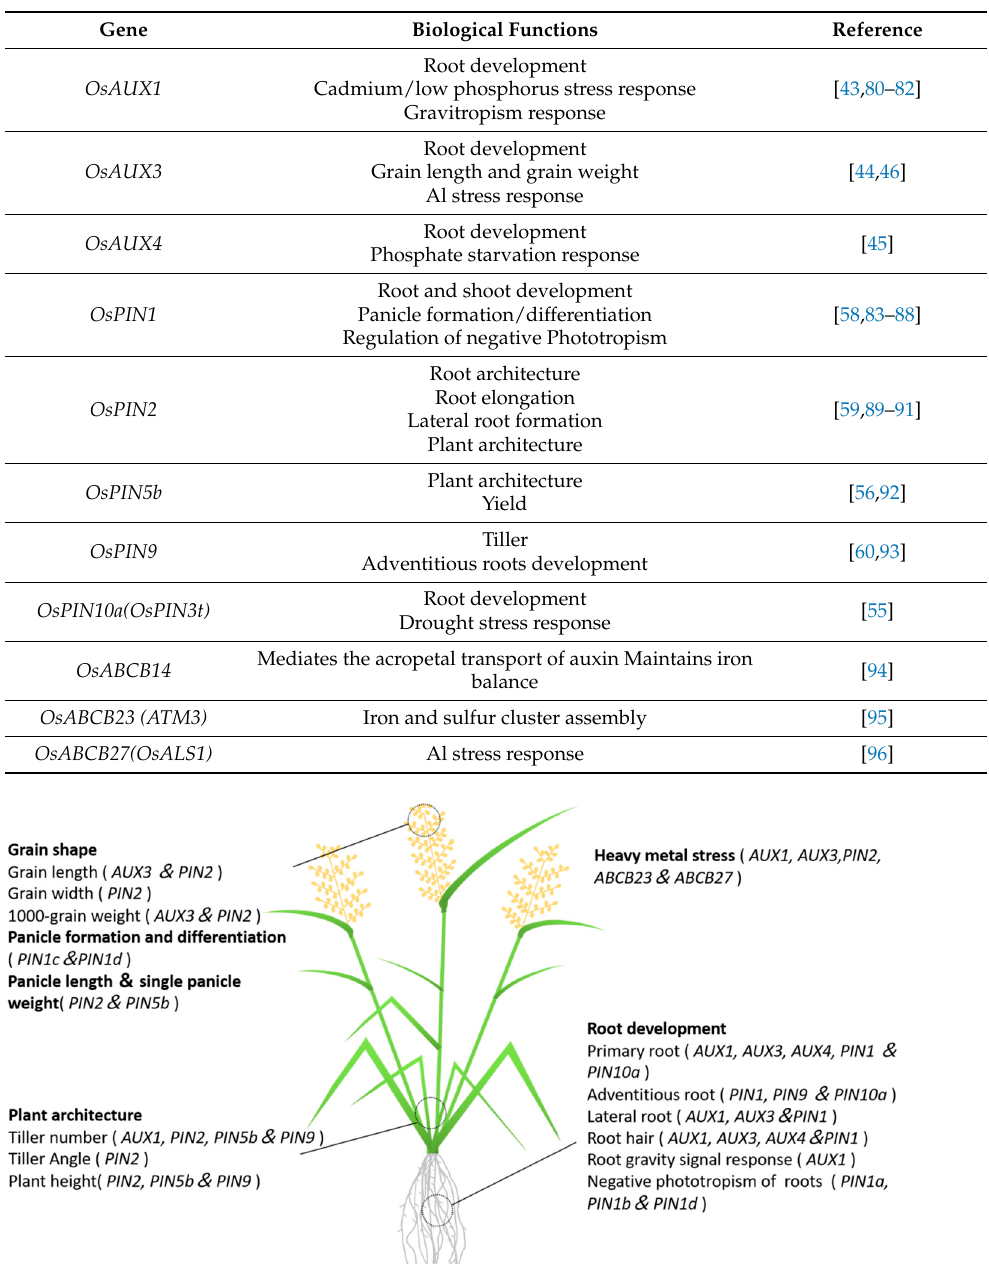
Figure 4. Roles of the OsAUX , OsPIN, and OsABCB family in rice development. Names in parenthesis indicate the genes controlling the respective role (refer to Yu et al., 2015 [43]; Wang et al., 2019